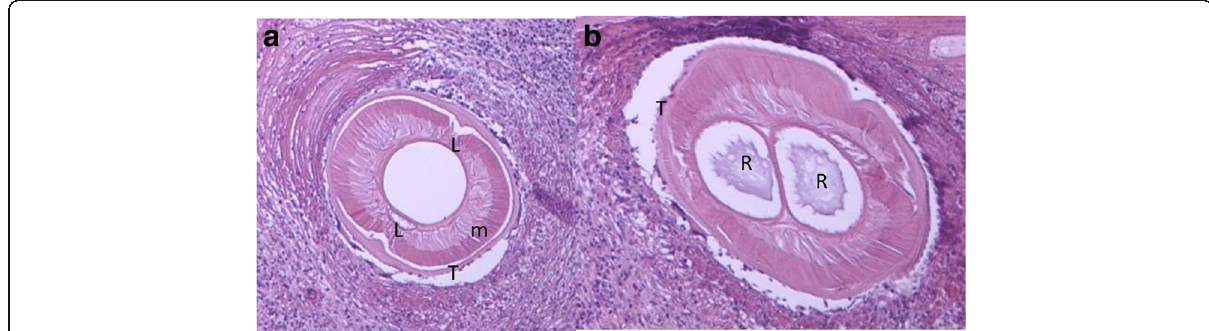
Fig. 1 a , b Paraffin section of Anisakis larva in a ventral subcutaneous lesion. m muscle, L lateral chord, R rennet cell, T transverse